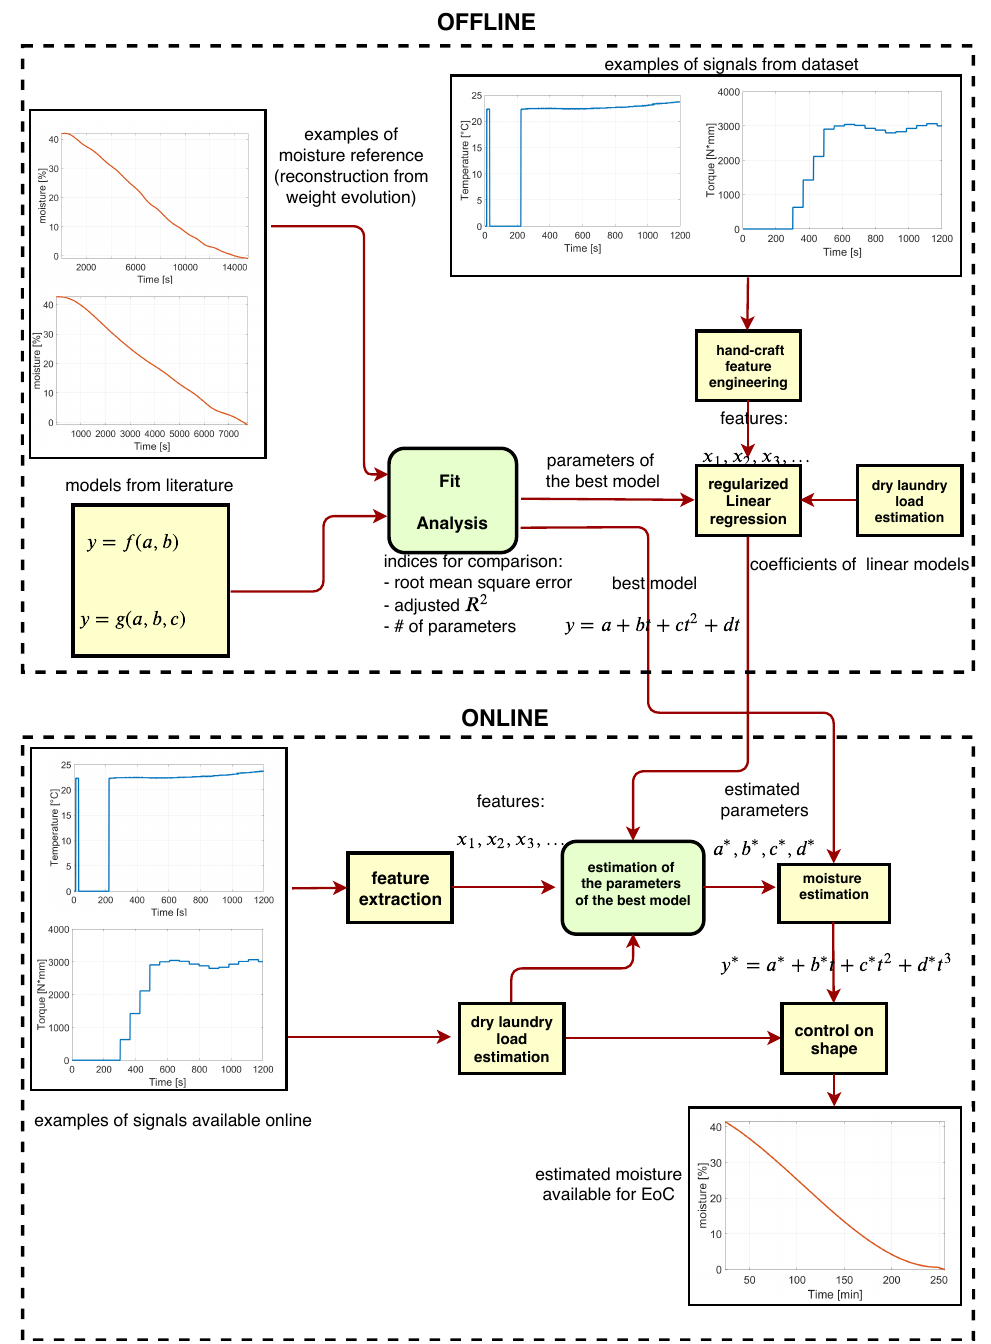
Figure 4. A Visual explanation of the algorithm proposed in Method